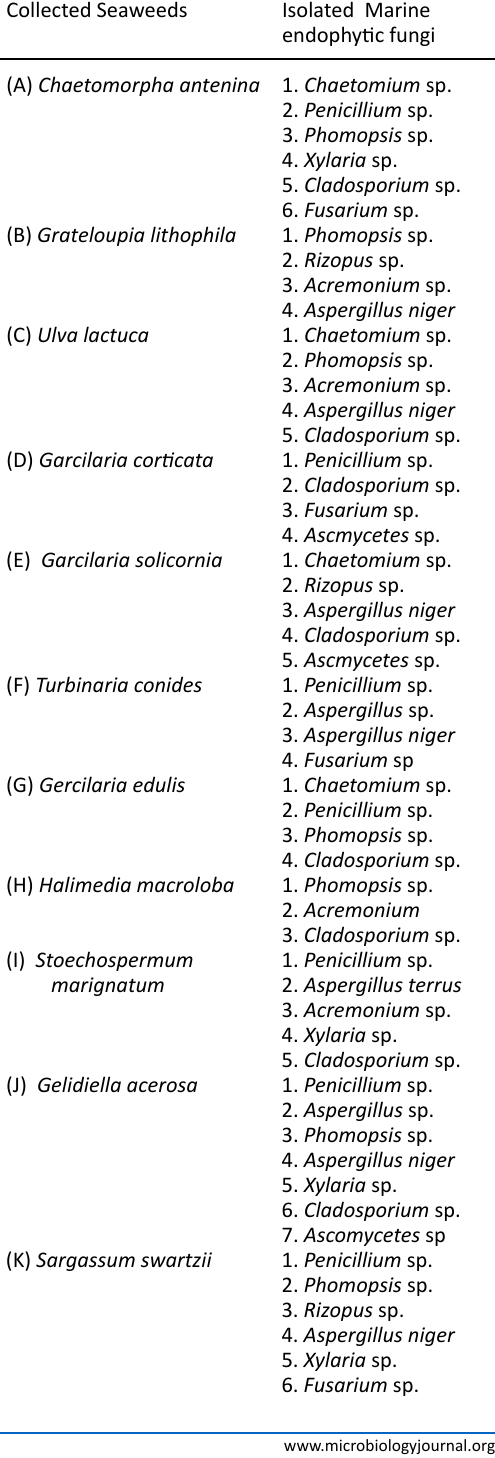
Table 3. Marine endophytic Fungus isolated from collected seaweed Collected Seaweeds Isolated Marine endophytic